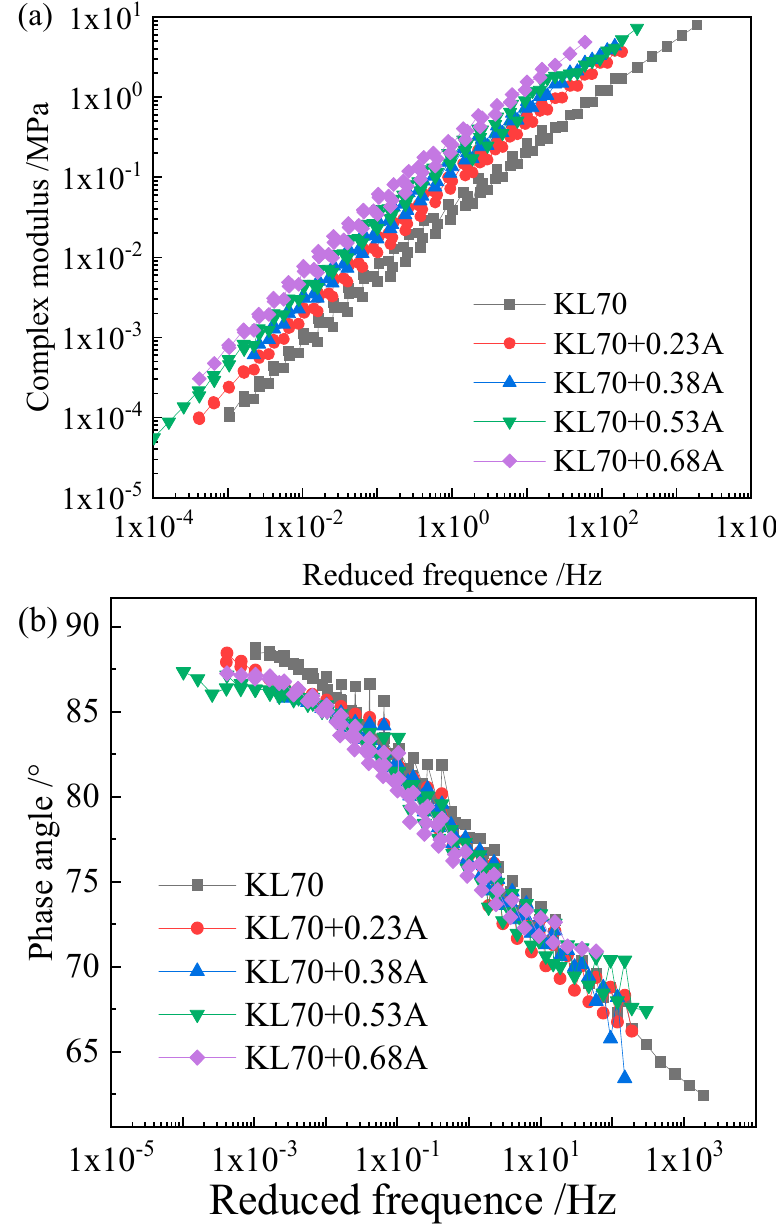
Figure 5. Master curve of complex modulus ( a ) and phase angle ( b ) of KL70 binder and mastics (A).